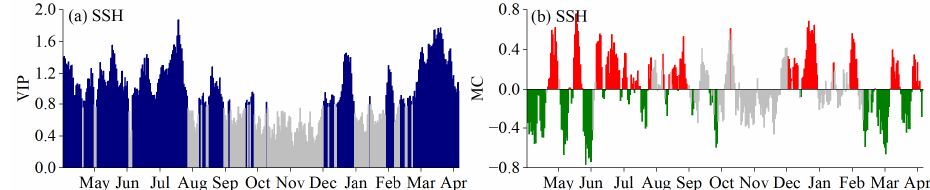
Figure 4. Results of partial least squares (PLS) regression correlating the start of the growing season (SOS) from 1985–2018 with 31-day running means of climatic factors. ( a , b ) Sunshine hours (SSH) from the previous May to April of the year.